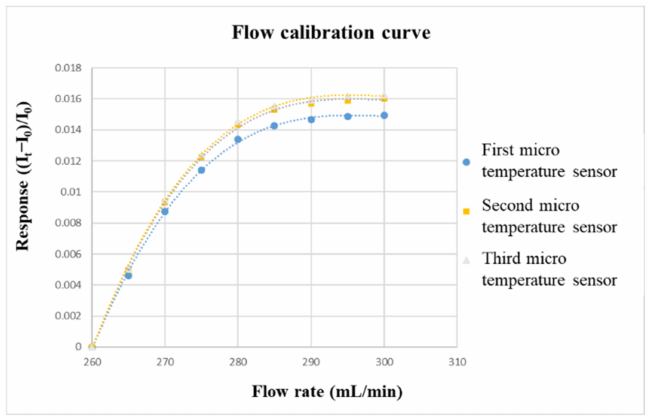
Figure 9. Flow-calibration curve.